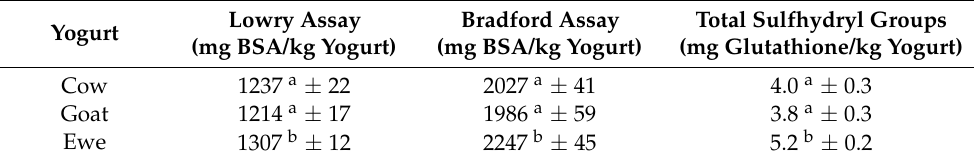
Table 6. Protein and total sulfhydryl groups content of cow, goat and ewe yogurt preparations obtained by pH adjustment and precipitation (pHAP) procedure 1